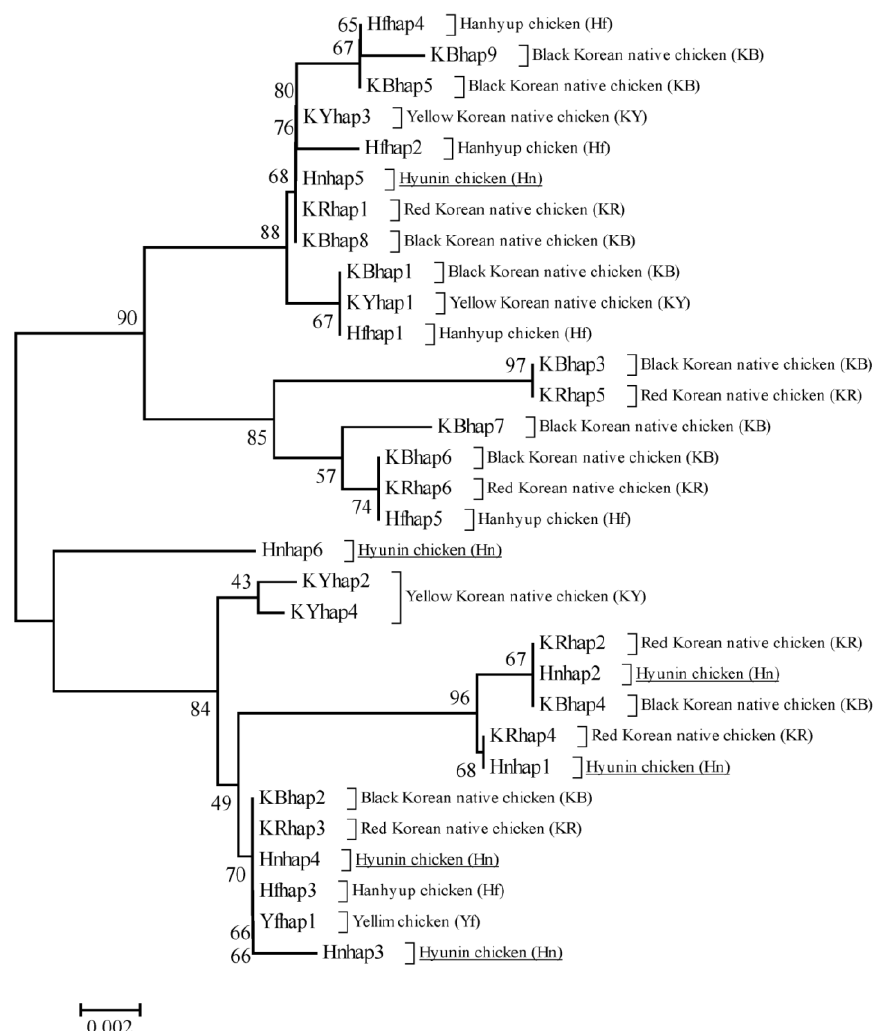
Figure 2. The neighbor-joining phylogenetic tree using Kimura 2-parameter model with 1000 bootstrap replications in six Korean native chicken